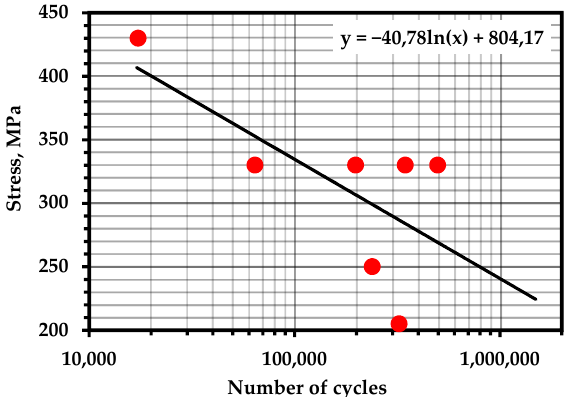
Figure A13. S–N Curve—Steel AISI 316LN (Temperature—293 К ; frequency—10 Hz; R = 0.1) [106]. Figure A14. S–N Curve—4330V (accepted as an analogue) (Temperature—293 К ; frequency—50 Hz) [107].